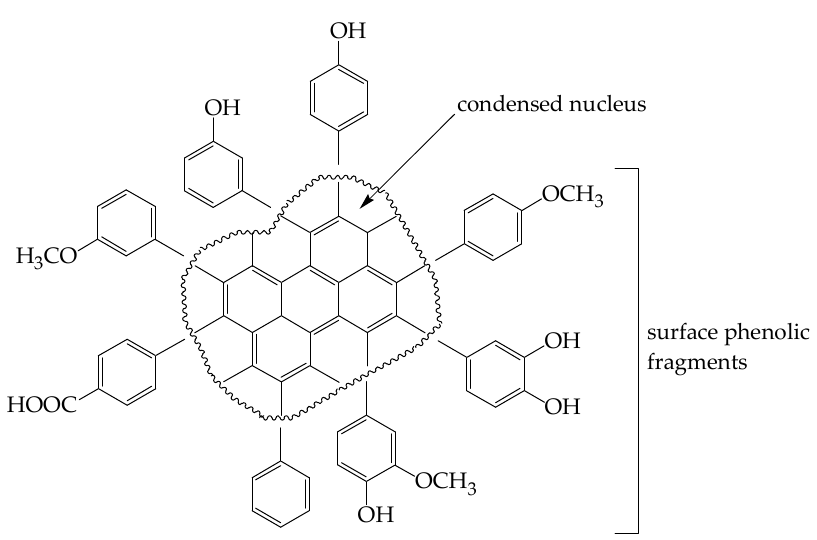
Figure 8. Hypothetical structure of E. angustifolium melanoidin EAM.